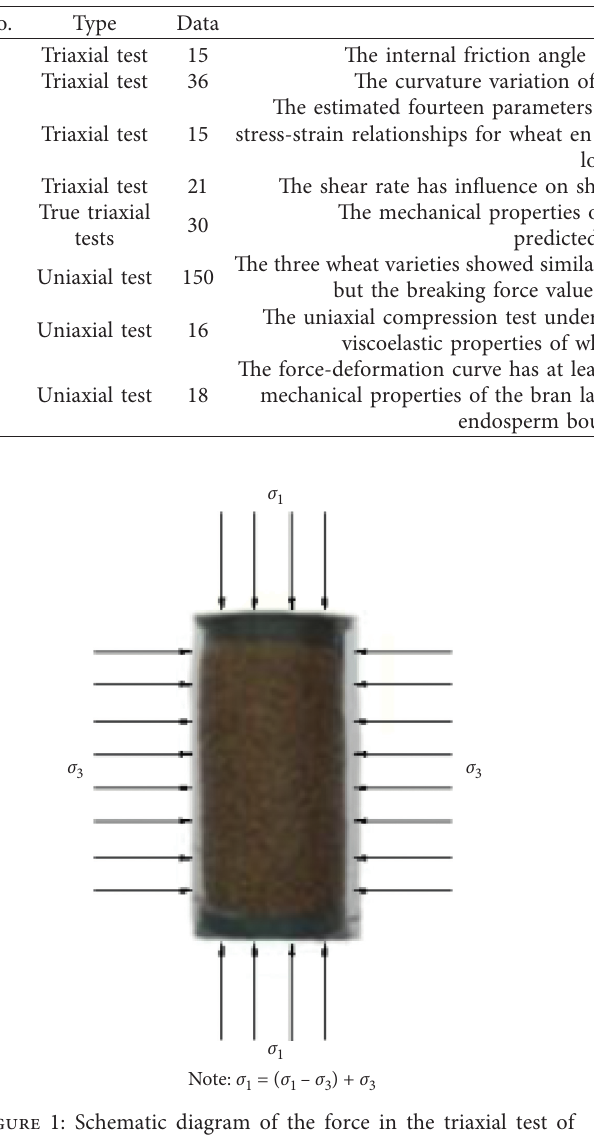
Table 1: Mechanical test of wheat.